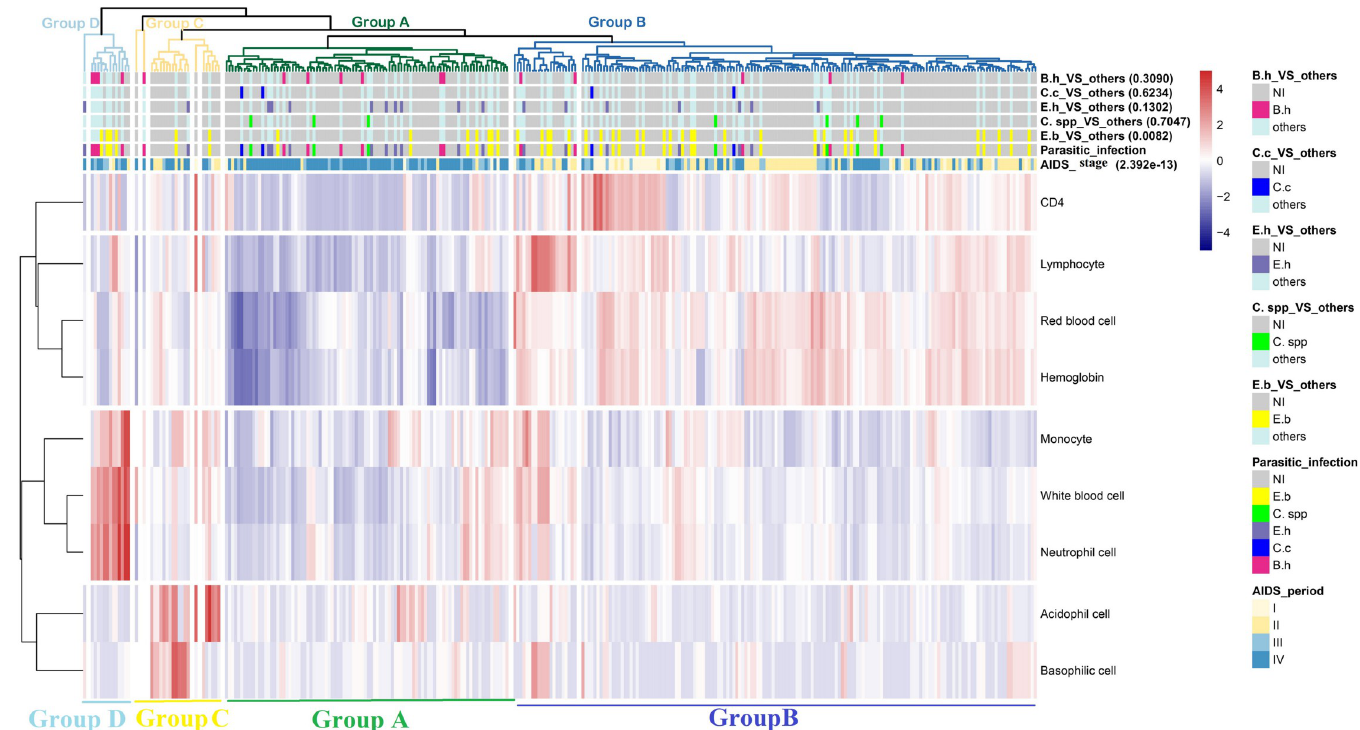
Fig 4. Clustering heatmap of the infection data. Among the 7 color bars, the bottom two are parasitic infection statuses and AIDS periods, and different colors represent different kinds of parasitic infections or different AIDS stages. The remaining 5 color bars are derived from the parasitic infection variable. For instance, in the group of “E.b._VS_other”, samples with parasitic infection of E.b. make up the group of interest, and parts 2 to 5 are separated into another group, while the uninfected group is comprised of samples with no parasitic infection. The other group and the non-infected group are labeled with cyan and gray colors, respectively. The group of interest is marked with a distinct color corresponding to the color in the parasitic infection status (NI, not infected; E.b., E . bieneusi ; C. spp., Cryptosporidium spp.; E.h., E . histolytica ; C.c., C . cayetanensis ; B.h., B . hominis